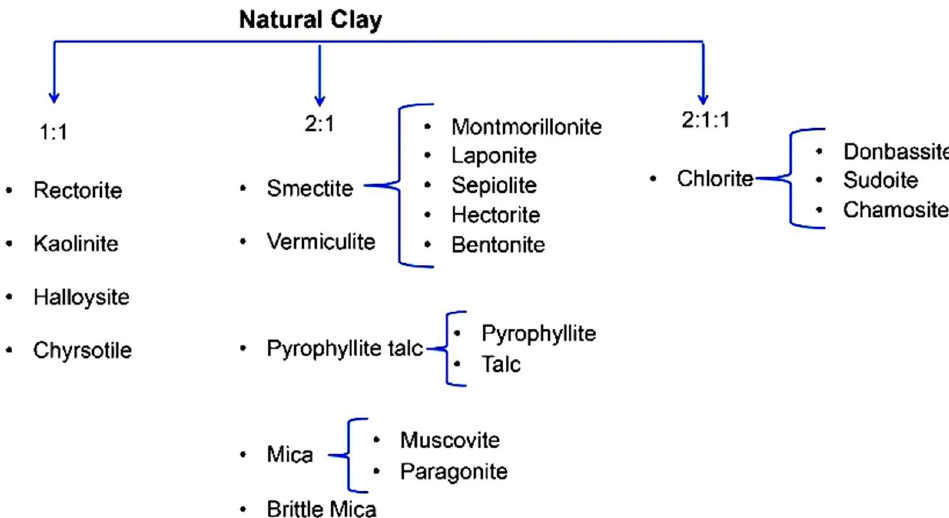
Figure 1. Different types of c lay and their classifications.